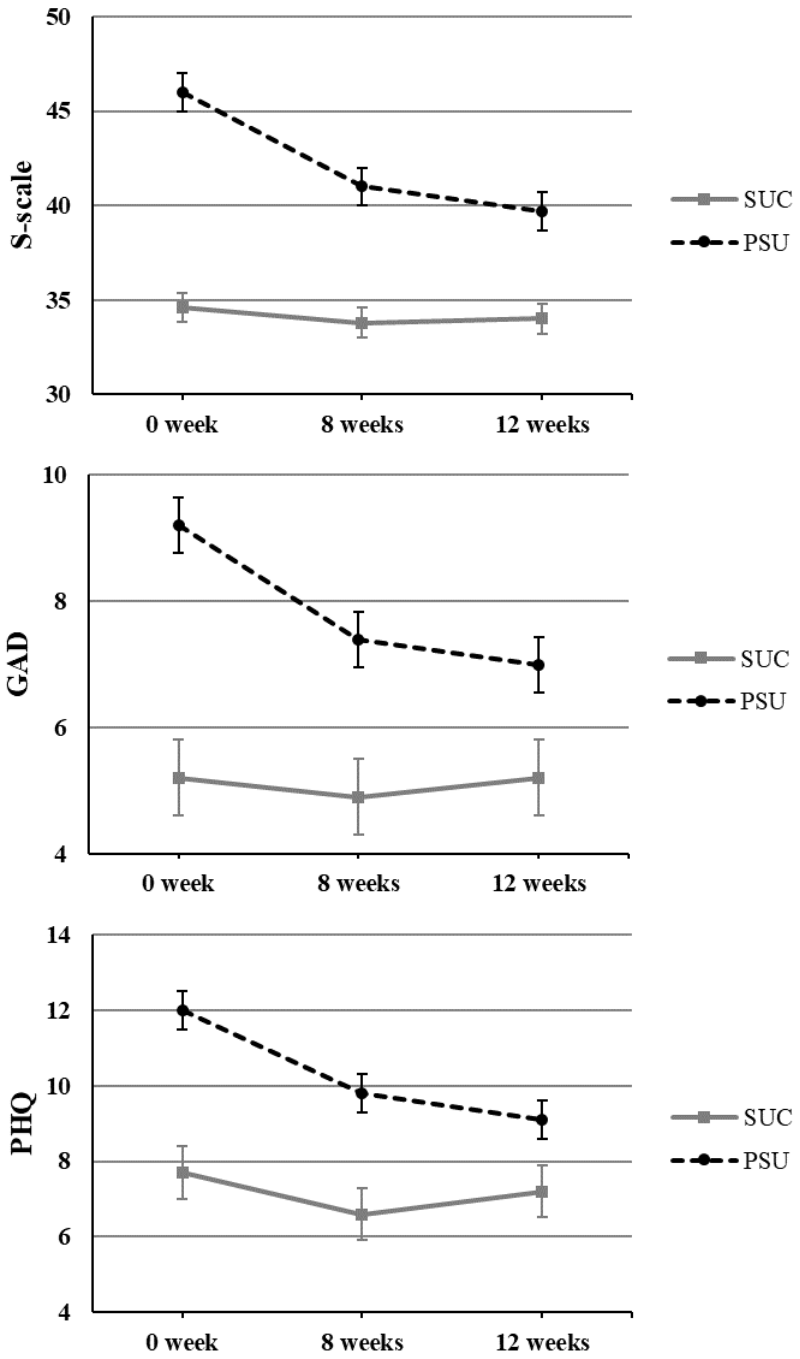
Figure 4. Results of linear mixed effects models of the post hoc analysis (S-scale, GAD, PHQ).